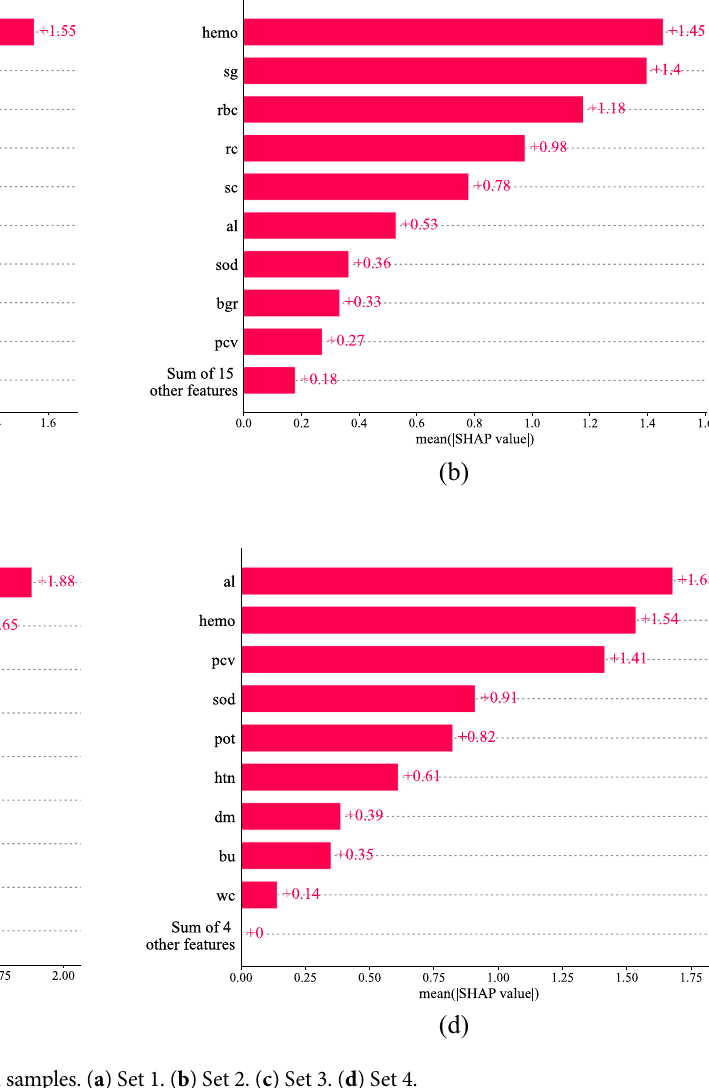
Figure 6. SHAP analysis on all samples. ( a ) Set 1. ( b ) Set 2. ( c ) Set 3. ( d ) Set 4.